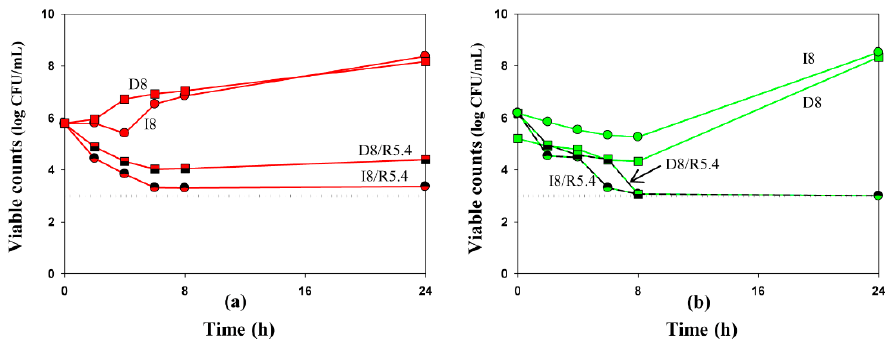
Figure 3. Time-kill curves at average steady-state concentrations of imipenem (circles) and doripenem (squares), alone and in combination with relebactam against K. pneumoniae 16 ( a ) and ATCC BAA-1902 ( b ). Dosing regimens are indicated at each curve. Dotted lines indicate the limit of detection. Data are presented as arithmetic means. Standard deviations are not shown as the data point difference was negligible.